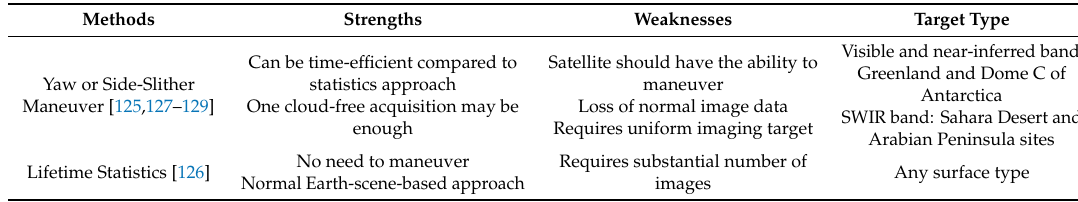
Table 3. Relative calibration